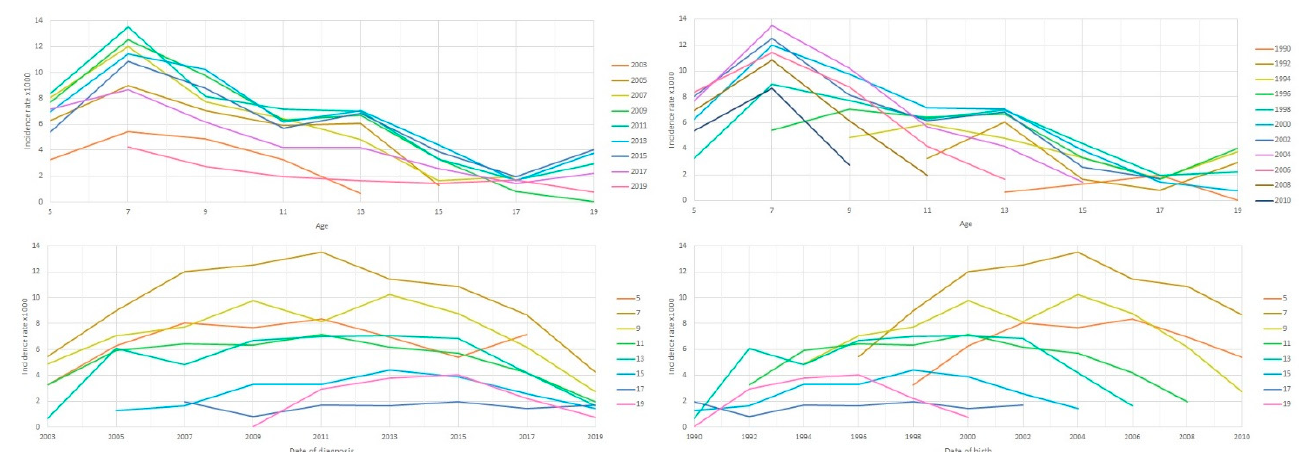
Figure 1. Rates of ADHD (per 1000 person-years) in Navarre 2003–2019 in ages 5–19 years. ( Top left ): age-specific rates by period of diagnosis. ( Top right ): age-specific rates by date of birth. ( Bottom left ): period-specific rates by age. ( Bottom right ): cohort-specific rates by age.